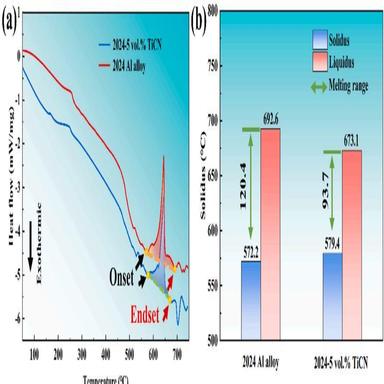
(a) DSC curves and (b) melting temperature range of the pure 2024 Al alloy powder and the 2024-5 vol% TiCN powder mixture.